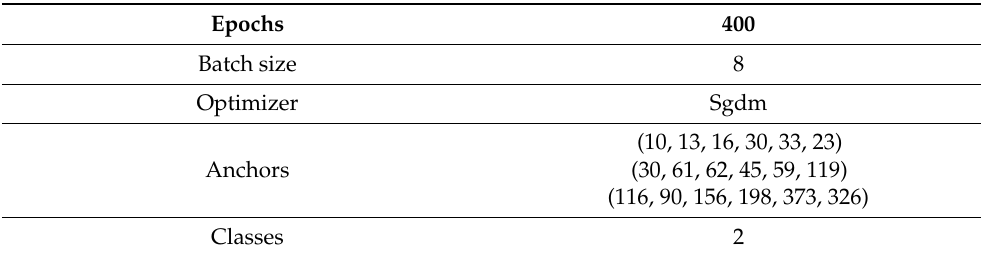
Table 1. Parameters of YOLOv5 training.